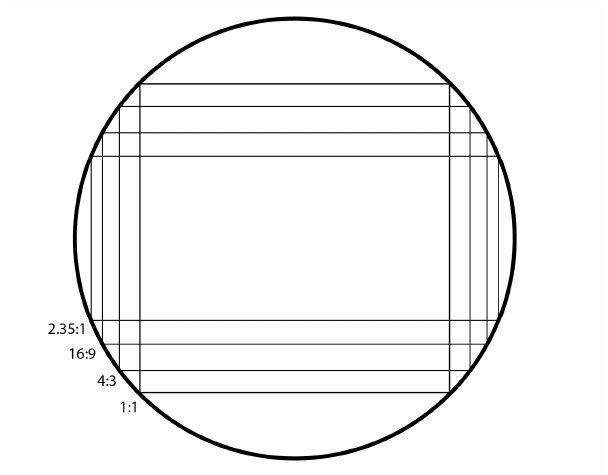
Figure 1. Relationship between the aspect ratios: TV (4:3), widescreen (16:9) and CinemaScope (2.35:1).